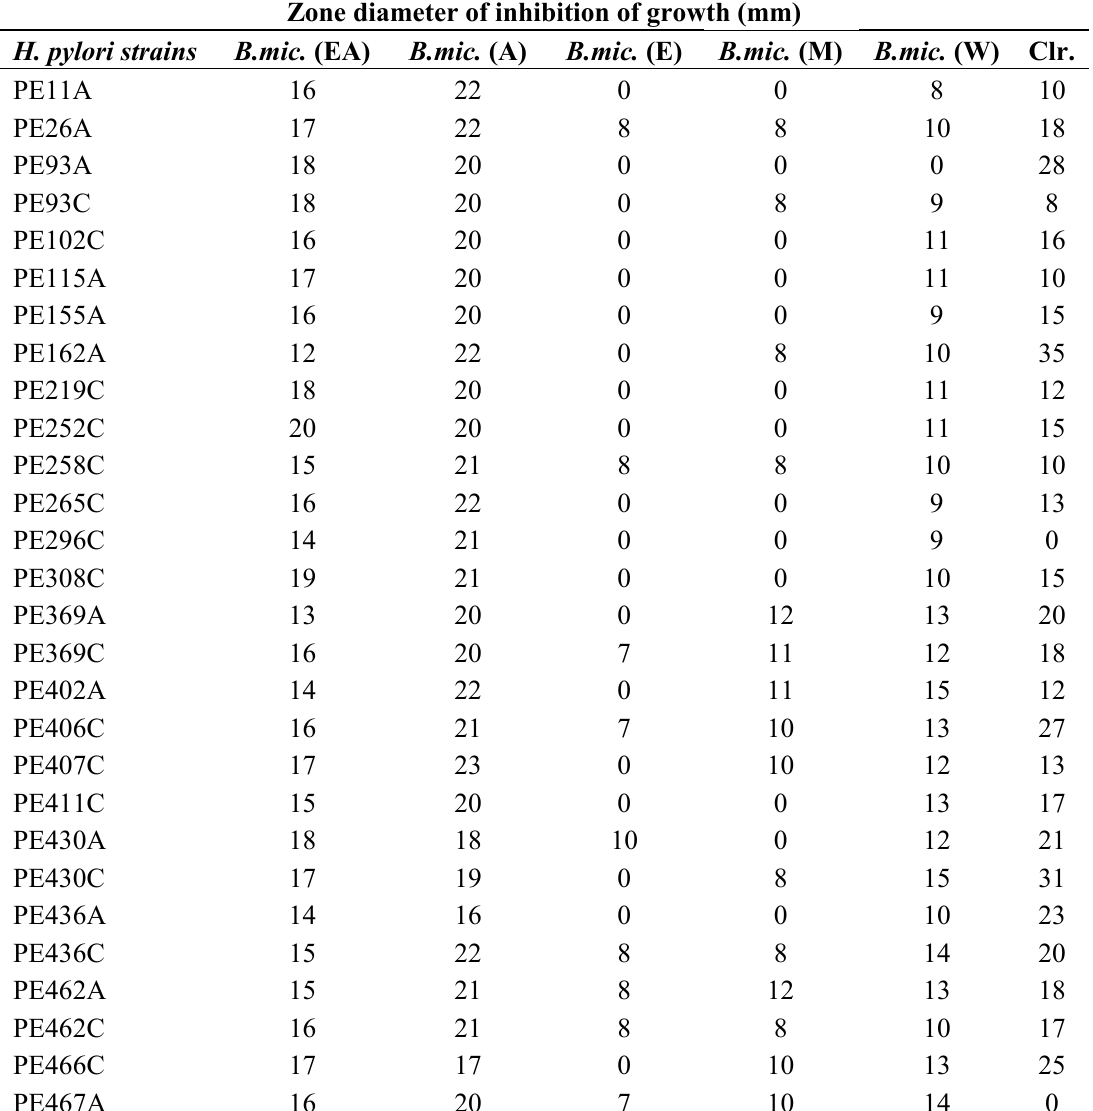
Table 1. Antibacterial activity of plant extracts against Helicobacter pylori strains. Zone diameter of inhibition of growth